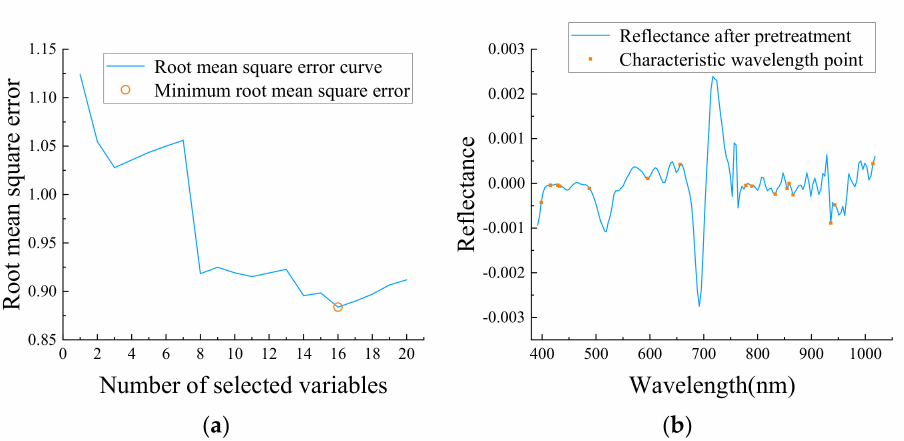
Figure 14. MCUVE–SPA screening the optimal combination wavelength results. ( a ) Trend of RMSEP value with the number of wavelengths. ( b ) Corresponding characteristic wavelength.